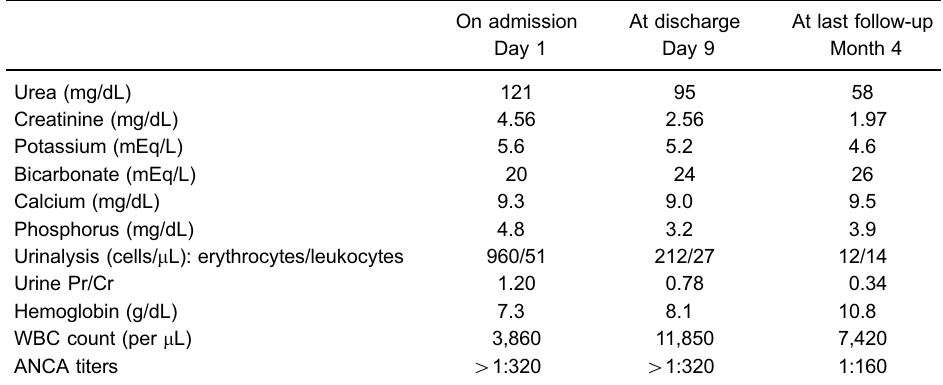
Pr/Cr: protein to creatinine ratio; WBC: white blood cells; ANCA: anti-neutrophil cytoplasmic